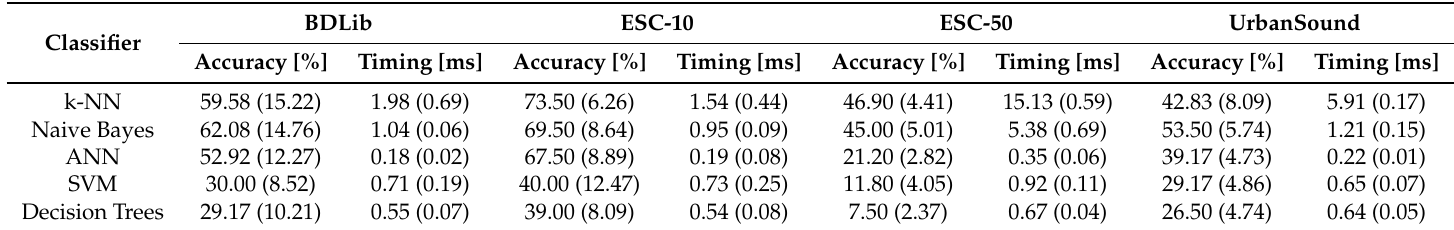
Table 4. Measured classifiers’ accuracy per dataset and average execution time of the classifiers with default configuration. Accuracy and timing values are expressed in percentage and milliseconds, respectively. The values in brackets are the Standard Deviation